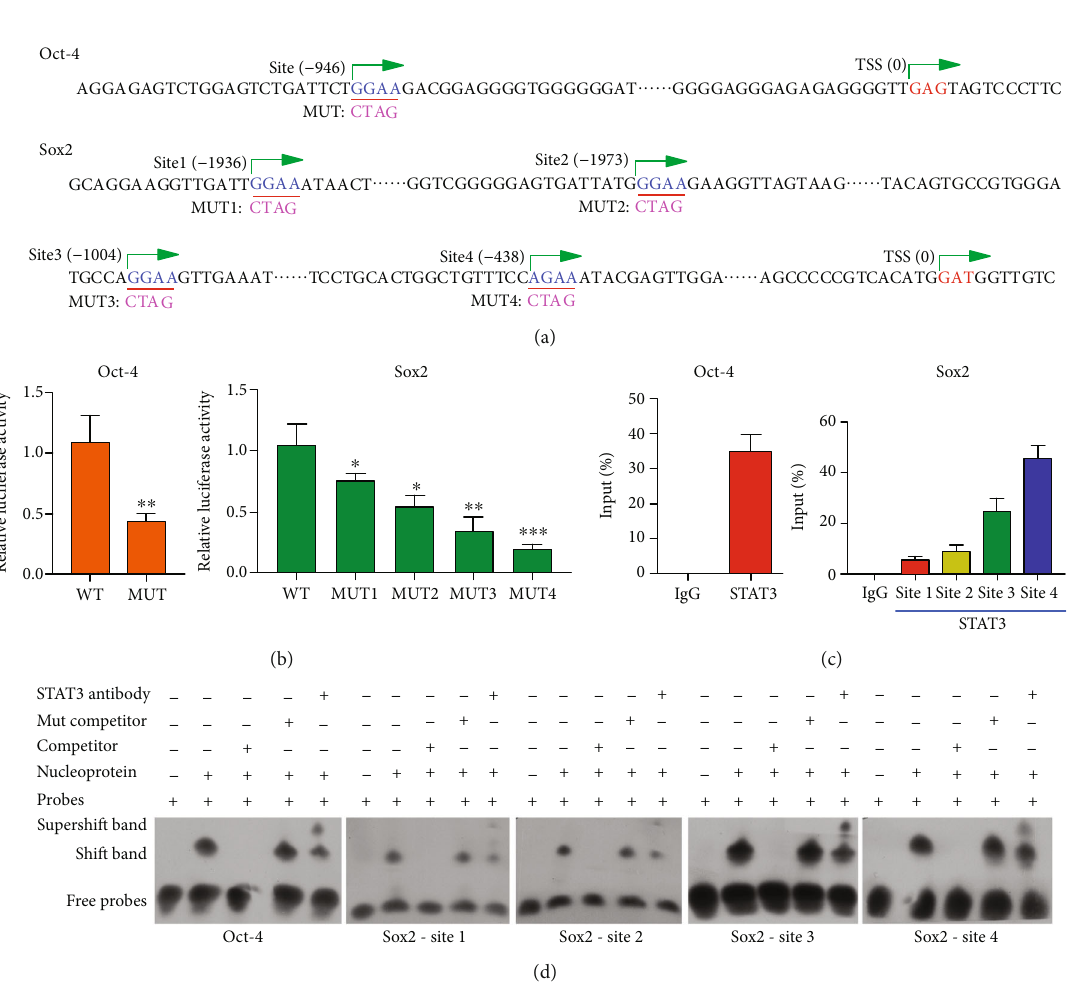
Figure 7: STAT3 bound to the endogenous Oct-4/Sox2 promoters. (a) Oligonucleotide sequences indicating the Oct-4/Sox2 promoters and the distance from the transcription start site (TSS) are shown. Green arrows denote the transcription direction. (b) The relative luciferase activities of the Oct-4 and Sox2 mutants were signi fi cantly decreased when compared with the STAT3 mimic in cotransfected 293 T cells. Data are represented as the mean ± SD . ∗ P < 0 : 05 , ∗∗ P < 0 : 01 , and ∗∗∗ P < 0 : 001 ; wild-type (WT) vs. mutation (MUT). (c) STAT3 binding to the endogenous Oct-4 and Sox2 promoters was evaluated by the chromatin immunoprecipitation assay. The levels of Oct-4 and Sox2 promoter regions in the lower chamber DPCs were signi fi cantly higher than those in the control group. (d) The binding sites for STAT3 on Oct 4 and Sox2 were detected by the electrophoretic mobility shift assay (EMSA) performed with DIG-labeled oligonucleotide probes (lane 2). Incubation with a speci fi c competitor abolished the binding (lane 3), while addition of a mutant competitor increased the intensities of the putative bands (lane 4). Moreover, incubation with STAT3 antibody reduced the intensities of those bands while causing an upward super shift (lane